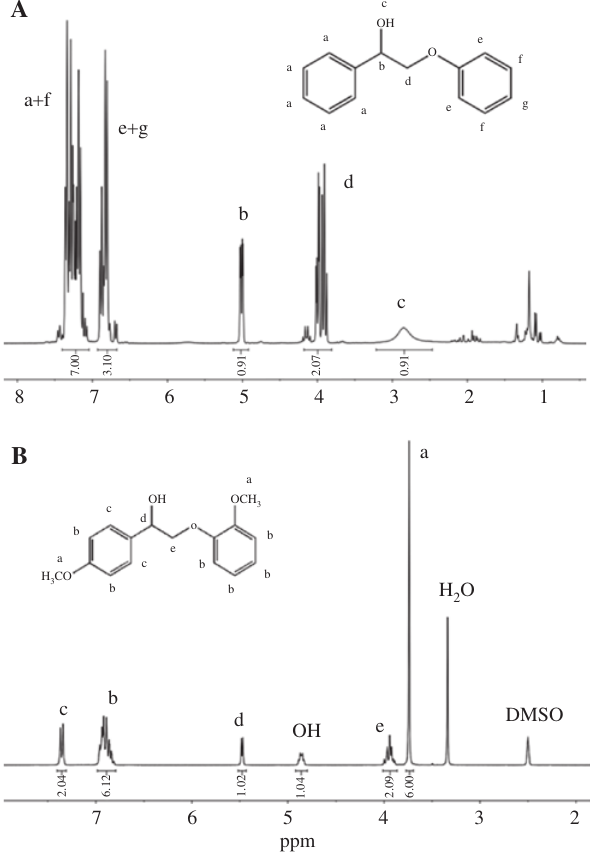
Figure 1: 1 H-NMR of the model compounds (A, 2-phenoxy-1- phenyle thanol) and [B, 2-(2-methoxyphenoxy)-1-(4-methoxyphenyl) ethan-1-ol].